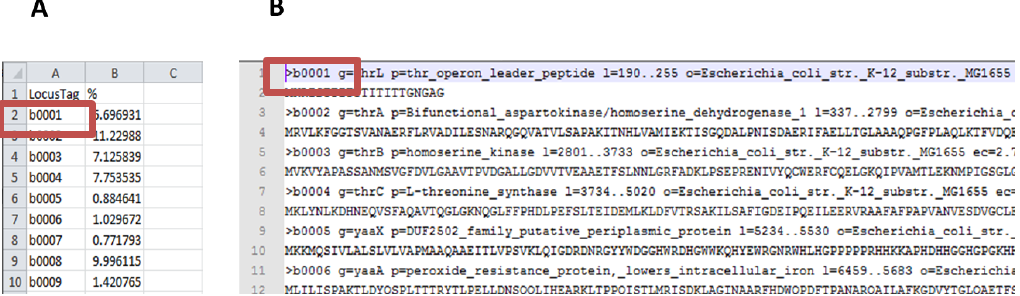
Figure 3: Screen-shots from the files used to estimate the biomass composition in amino acids for E. coli . (A) Csv file with gene/protein identifier and respective expression factor and (B) FASTA file with all protein sequences, where the same identifier is used for each sequence.